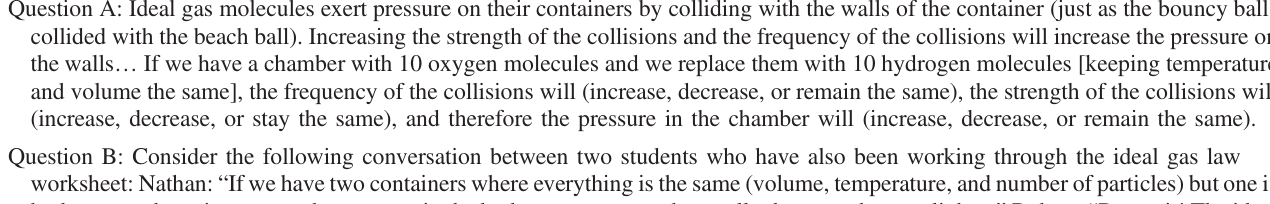
TABLE II. Changing gas question and solution. Question A: Ideal gas molecules exert pressure on their containers by colliding with the walls of the container (just as the bouncy balls collided with the beach ball). Increasing the strength of the collisions and the frequency of the collisions will increase the pressure on the walls … If we have a chamber with 10 oxygen molecules and we replace them with 10 hydrogen molecules [keeping temperature and volume the same], the frequency of the collisions will (increase, decrease, or remain the same), the strength of the collisions will (increase, decrease, or stay the same), and therefore the pressure in the chamber will (increase, decrease, or remain the same). Question B: Consider the following conversation between two students who have also been working through the ideal gas law worksheet: Nathan: “ If we have two containers where everything is the same (volume, temperature, and number of particles) but one is hydrogen and one is oxygen, the pressure in the hydrogen case must be smaller because they are lighter. ” Robert: “ But wait! The ideal gas law says the pressure is the same ( P ¼ nRT=V ). But something must be different if the masses are different …” Do you agree with Nathan, Robert, or neither? How can you make their reasoning more complete based on your previous answers? Possible normative response: If mass decreases and temperature is the same, velocity and therefore the frequency of collisions increases. We cannot tell if the strength of collisions increases, decreases, or stays the same because it depends on mass (which decreases) and velocity (which increases). But from the ideal gas law, we know that pressure remains the same so since frequency goes up, the collisional strength must go down in equal amounts in order to give the same